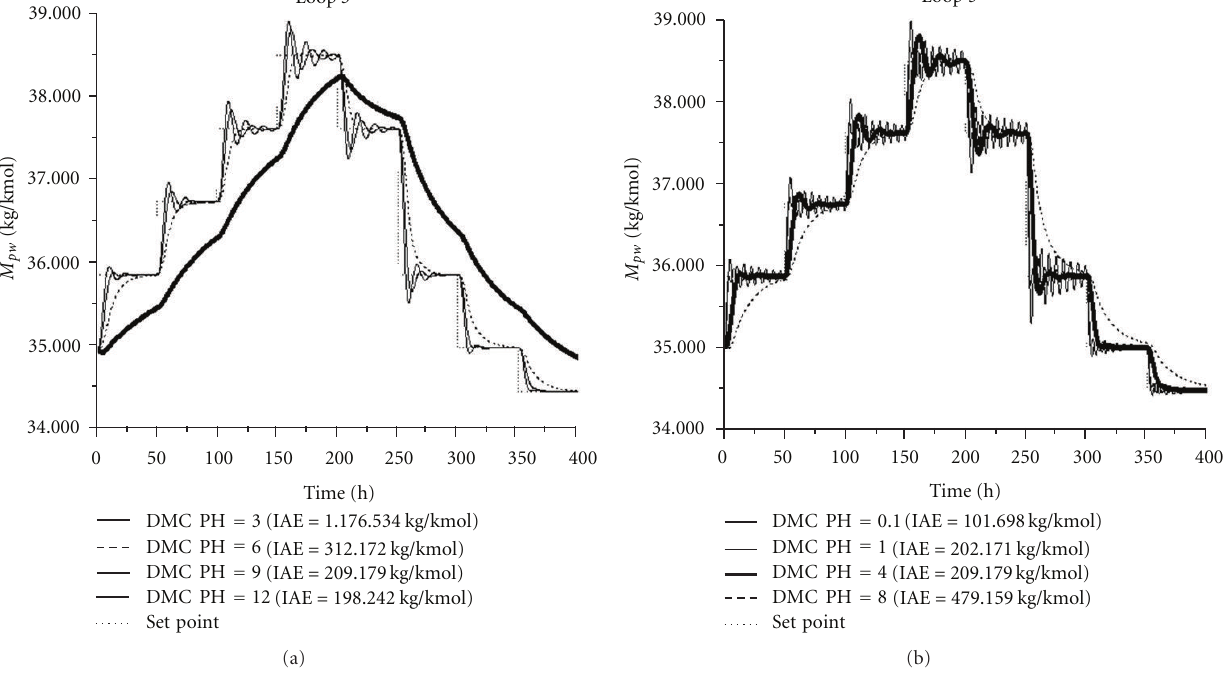
Figure 11: Closed-loop simulations for the servo problem for sensitivity analysis on PH and f .